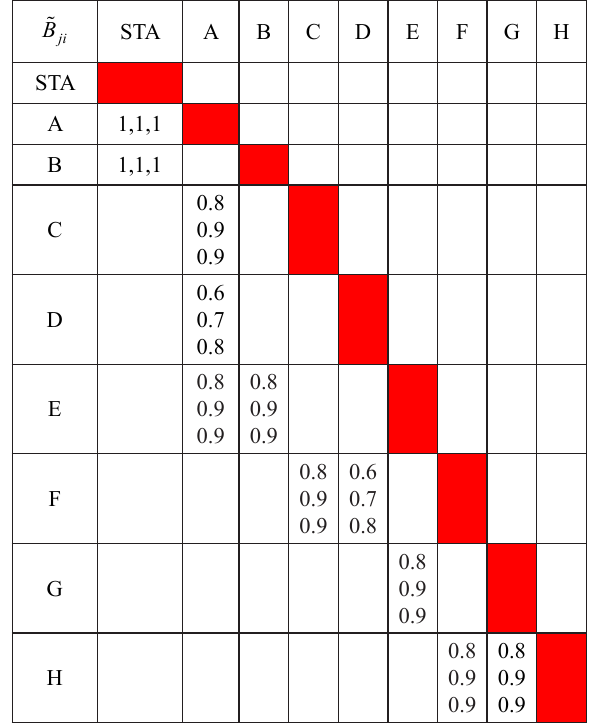
Table 3. Time variable calculations without overlaps